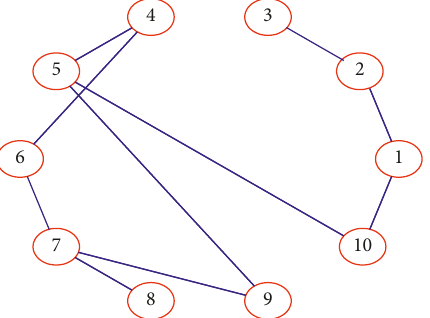
Figure 3: Interaction graph of 10 nodes.